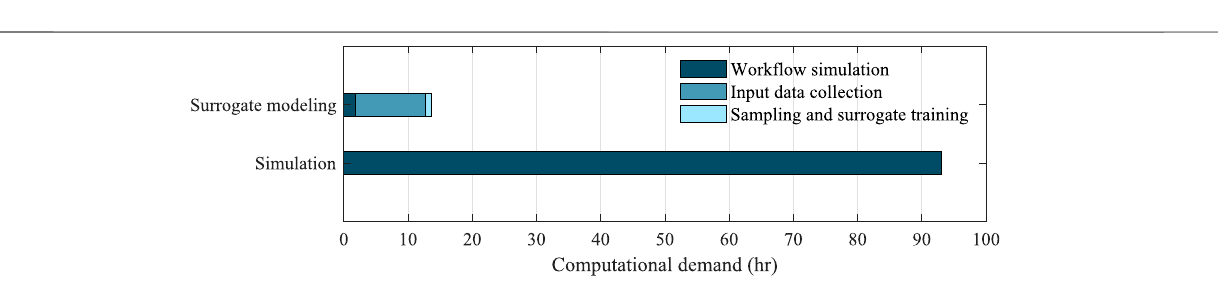
FIGURE 12 | Comparison of the processing time required for the estimation of labels in the testing set using different approaches.